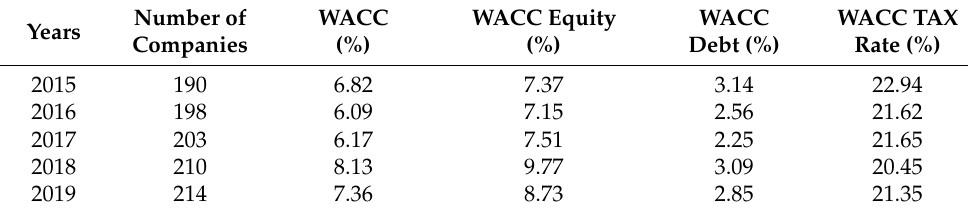
Table 4. WACC, WACC equity, and WACC debt in 2015–2019.